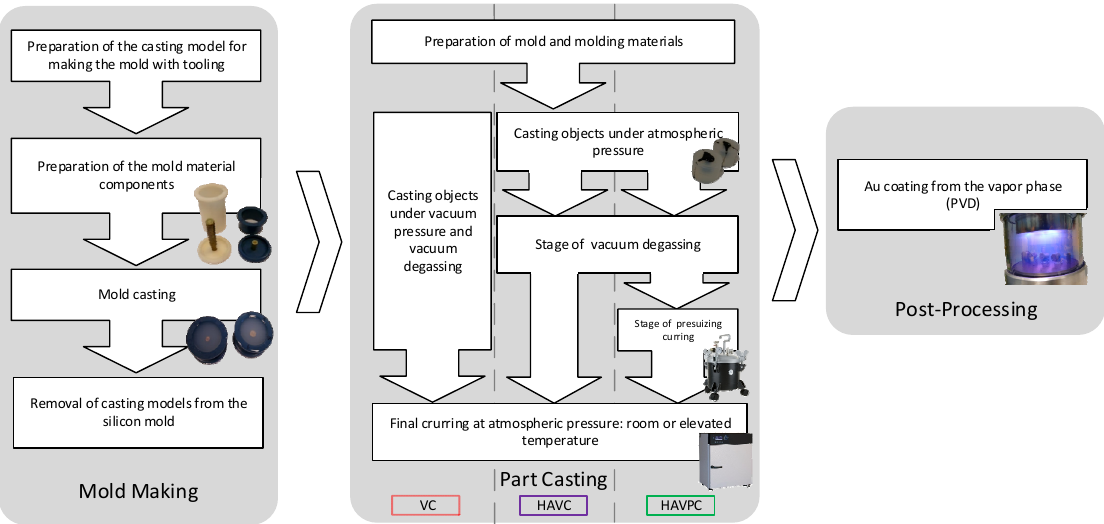
Figure 1. Schematic diagram of the technological process for replicating forensic marks.